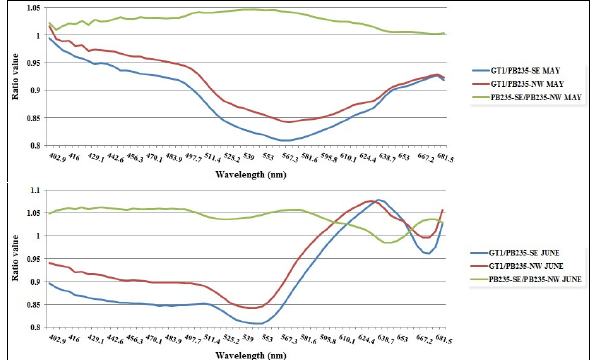
Figura 9. Ratios among spectra of the Rubber trees stands (GT1, PB235-SE and PB235-NW) from 400-700nm for May and June, in leaf Figure 6. Spectral behaviour in canopy scale, for May and June, in the region of 550nm of the Rubber trees stands: GT1, PB235- SE and PB235-NW